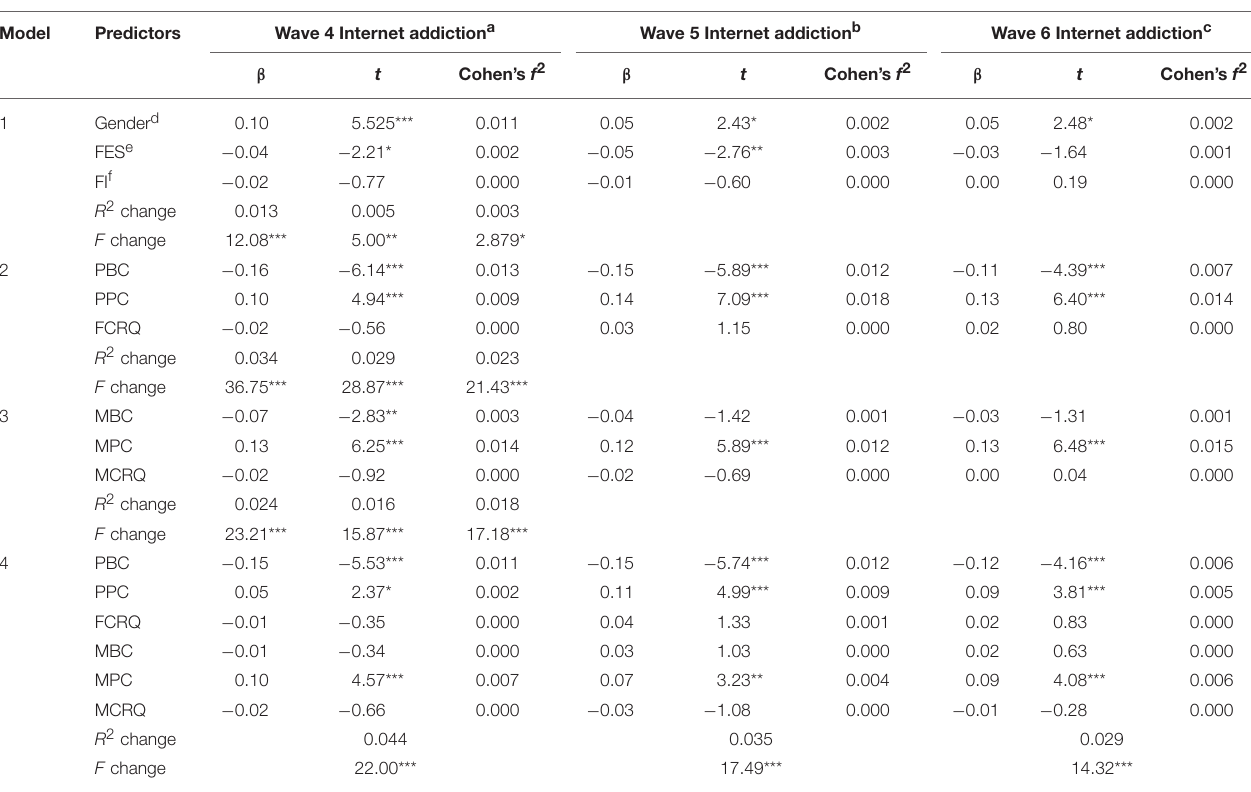
TABLE 7 | Concurrent predicting effects of parent–child subsystem qualities on Internet addiction.